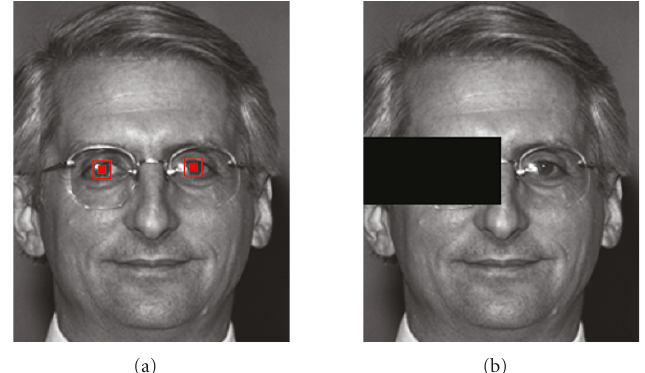
Figure 2: Face image of 203 × 251 pixels. (a) Image with eye position (red dot) and square showing a 10% error in the eye position. (b) Image with partial